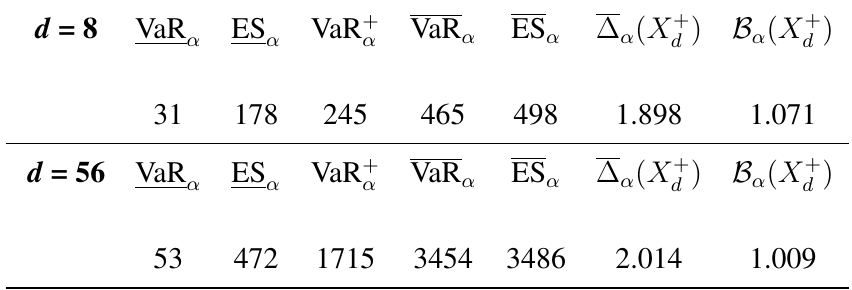
Table 4. Values (rounded) for best and worst VaR and ES for a homogeneous portfolio with d Pareto(2) risks; α = 0 . 999 . VaR + represents VaR in the comonotonic case. Comonotonic α values might not be strict multiples, because of